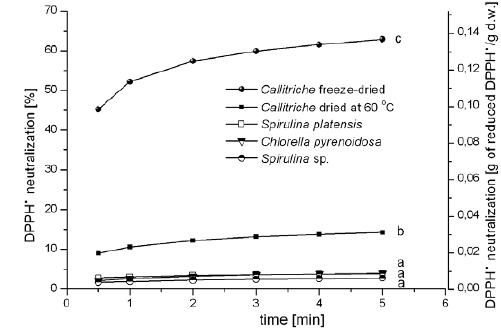
Figure 3. Radical scavenging activity of investigated extracts measured due to colorimetric DPPH • assay. Different letters indicate significant statistical differences (ANOVA, NIR-Fisher test; α = 0.05; n = 8 for all Callitriche samples; n = 3 for the other extracts).